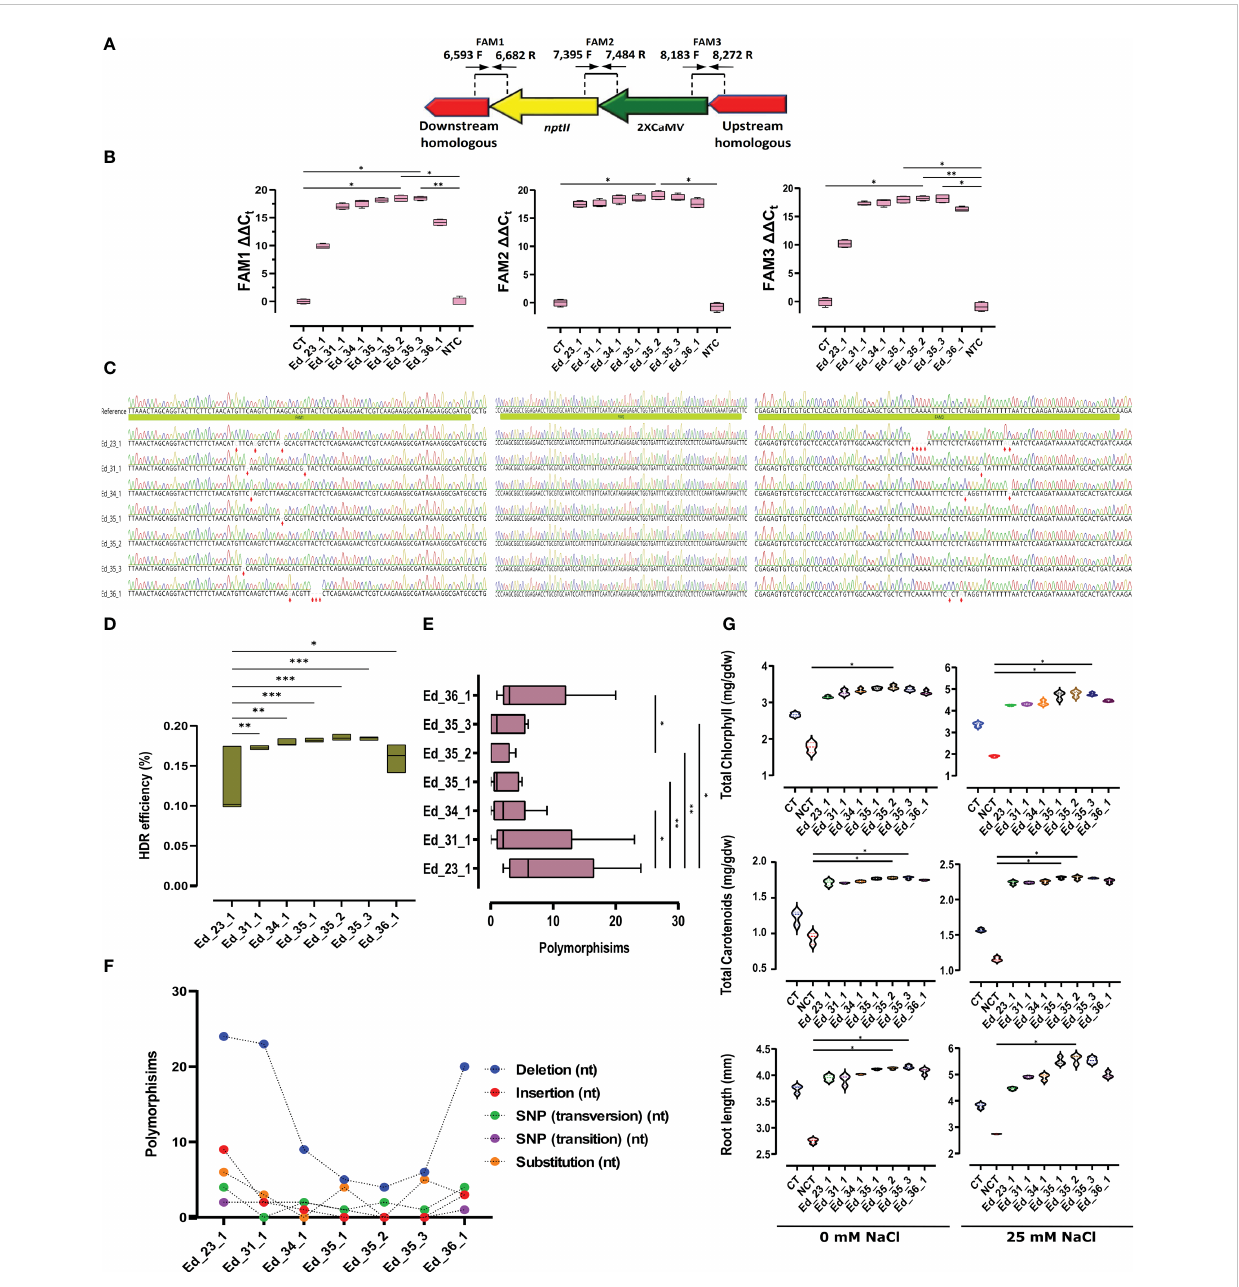
FIGURE 3 TaqMan real-time PCR exhibited ef fi cient HDR through ef fi cient transformant events. (A) Schematic FAM design to evaluate HDR ef fi ciency. (B) Ed_35_1, Ed_35_2, and Ed_35_3 exhibited more FAM signals than the CT and NCT lines. Especially Ed_35_2 revealed signi fi cantly more expression signals within FAM1, 2, and 3 than the recovered edited events. (C) Sanger sequencing to verify results achieved by FAM signals. (D) HDR ef fi ciency (%) evaluation calculated from the achieved FAM signals. Ed_35_1, Ed_35_2, and Ed_35_3 revealed more HDR ef fi ciency. (E) Mean comparison